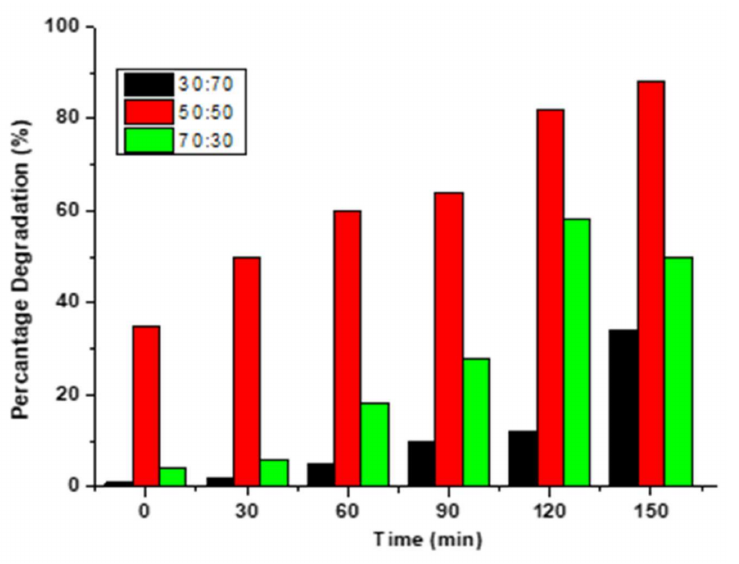
Figure 6. Photocatalytic degradation of MB